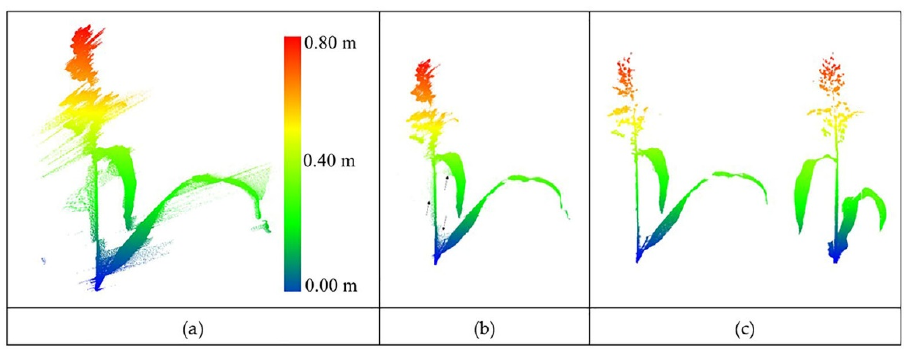
Figure 10. ( a ) Original LiDAR data with natural outliers. ( b ) Coarse-level outlier removal from a sorghum plant. Arrows show the residual outliers from this step. ( c ) Result of removal of residual outliers with two different views.